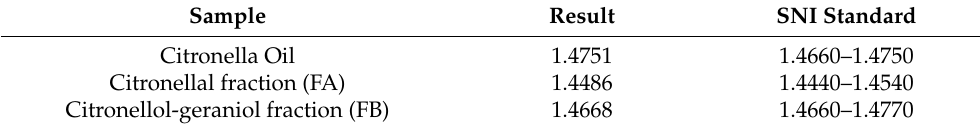
Table 7. The refractive index of Fractions of Citronella